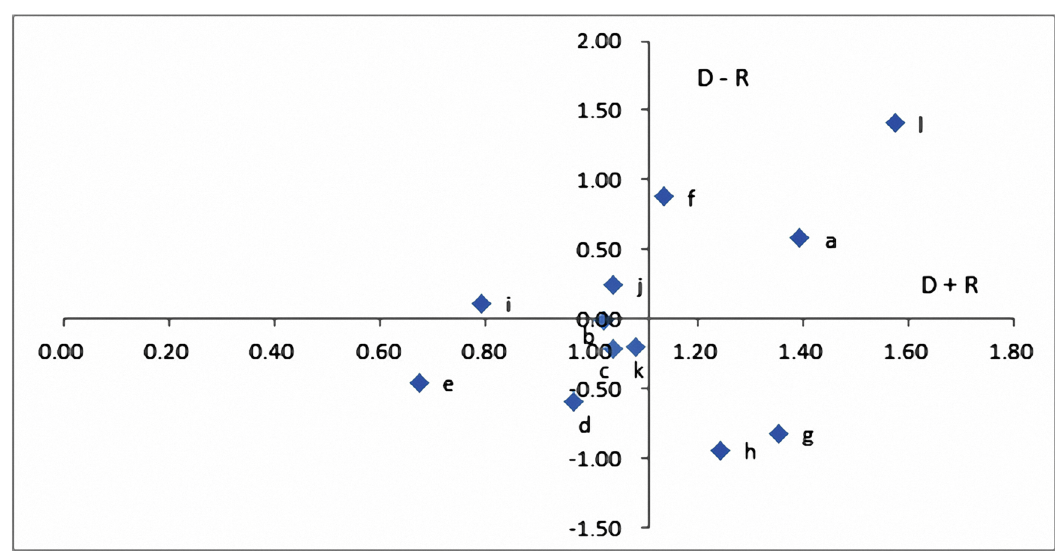
Fig 3. Relational diagram of the 12